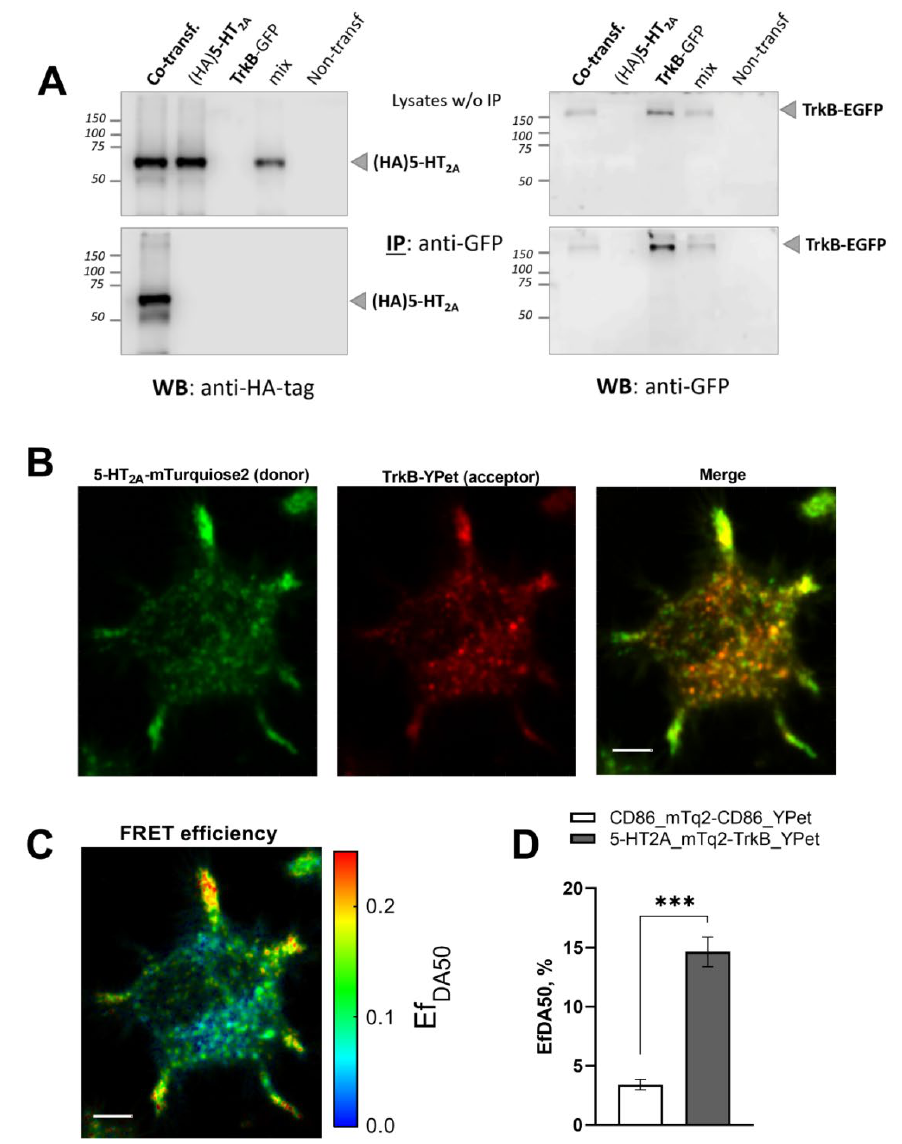
Figure 1. Interaction between receptors 5-HT 2A and TrkB in neuroblastoma N1E-115 cells. ( A ) Co- immunoprecipitation of recombinant HA-tagged 5-HT 2A and GFP (mEGFP)-tagged TrkB. Using a mixture of cells expressing each individual protein (mix) or cells that co-expressed both proteins (co-transfection), we performed immunoprecipitation (IP) with an anti-GFP antibody, followed by Western blot (WB) analysis with anti-GFP (right) and anti-HA (left) antibodies. Top: Expression of proteins before IP (lysate w/o IP). Bottom: Expression of proteins after IP. Results are representative of at least three independent experiments. ( B – D ) Specific interaction between 5-HT 2A -mTurquoise2 and TrkB-YPet. Cells co-expressing 5-HT 2A -mTurquoise2 and TrkB-YPet were analyzed using the lux-FRET method after confocal microscopy. ( B ) Distributions of 5-HT 2A -mTurquoise2 (donor) and TrkB-YPet (acceptor), and merged images quantified by linear unmixing of the fluorescence emission spectra. Scale bar, 5 µ m. ( C ) Apparent FRET efficiency (Ef DA ). A representative cell is shown. ( D ) Quantification of FRET efficiency (Ef DA ) between 5-HT 2A -mTurquoise2 and TrkB-YPet. *** p < 0.001 (one-way